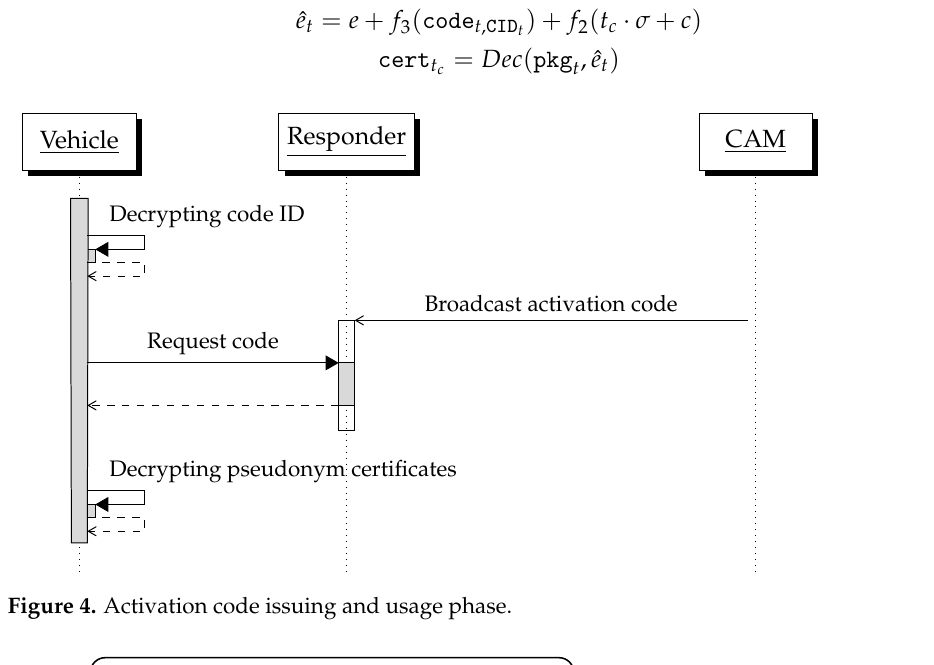
Figure 4. Activation code issuing and usage phase.